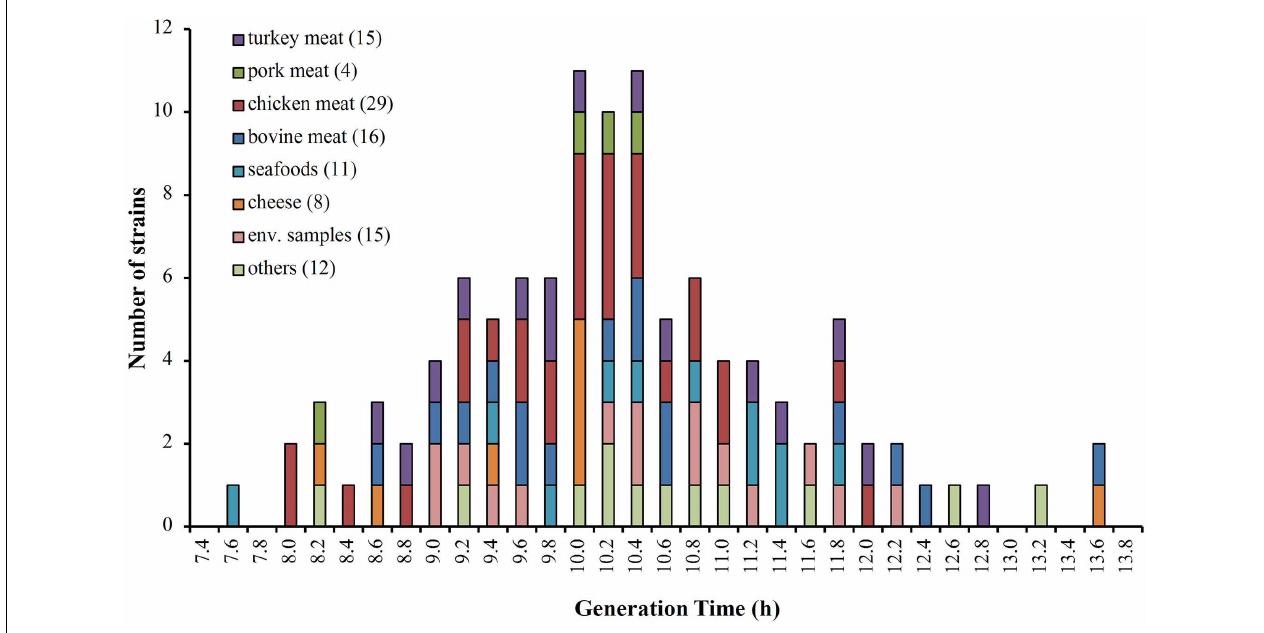
FIGURE 1 | Distribution of generation times (Gt) for 110 isolates of Listeria monocytogenes growing at 8 ◦ C. The colors indicate the food matrices from where the strains of L. monocytogenes were isolated. In parentheses the number of isolates by